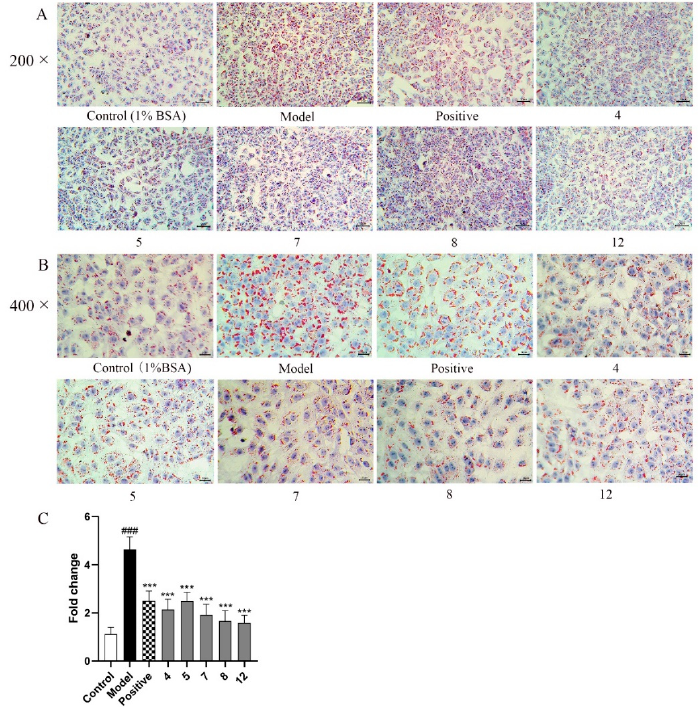
Figure 7. Oil red O staining of lipid droplets and quantitative analysis in BRL cells treated with or without 0.5 mM FFA mixed compounds 4 , 5 , 7 , 8, and 12 (10 µ M); ( A ) 200 × ; ( B ) 400 × ; ( C ) Quantitative analysis of red-stained cells. The images shown are representatives of 3 replicates of each. The values are presented as mean ± SEM. ### p < 0.001, vs. the control group; *** p < 0.001, vs. the model group.